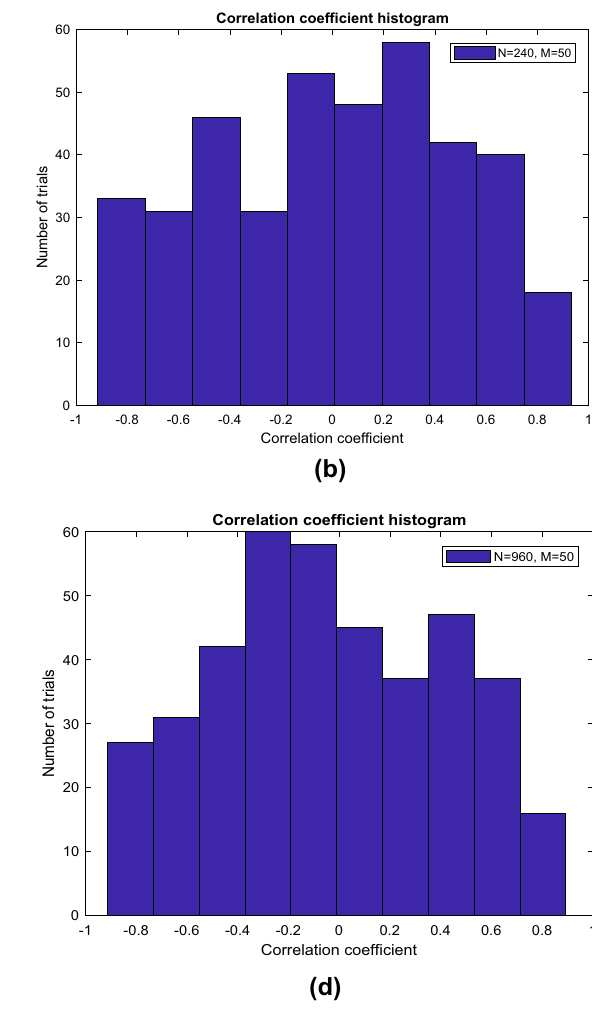
tions are skewed towards − 1 or 1, but remain relatively uniform over the whole interval, which indicates no reliable estimation